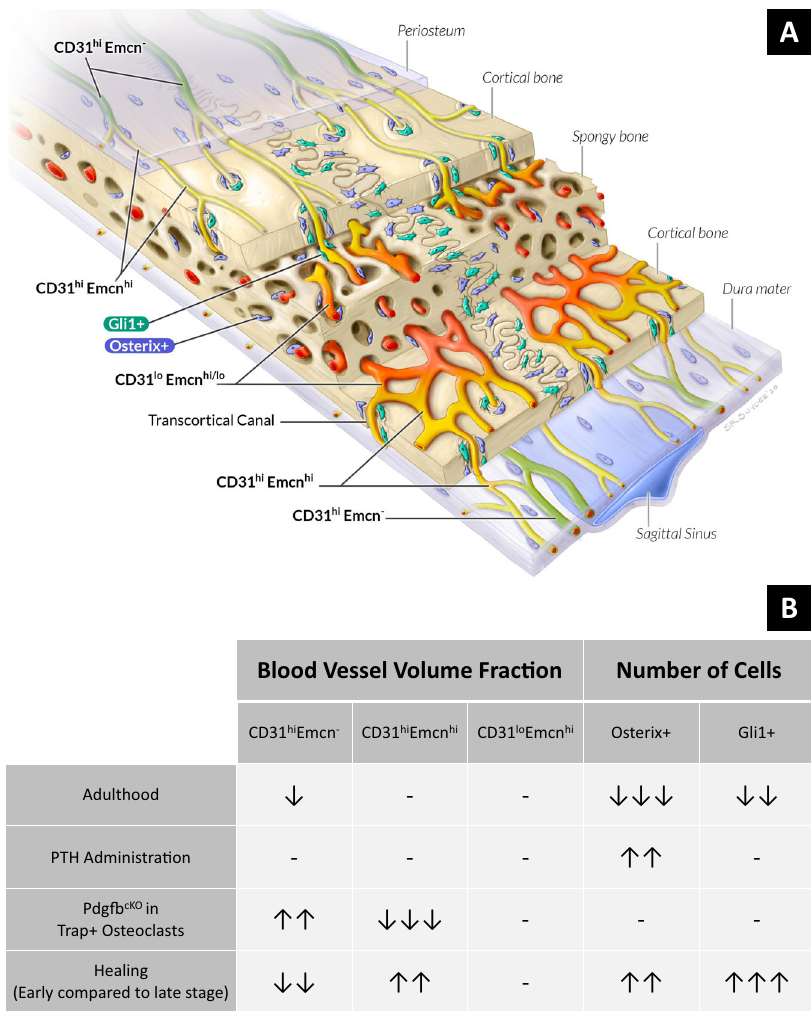
Fig. 7 Schematic representing the spatial distribution and prevalence of vessels and skeletal progenitors in the calvarium. A Illustration showing the relative locations of the vessel and skeletal progenitor subtypes in the parietal bones from 4-weeks-old mice, as derived from Fig. 2. B Table demonstrating how the fractional volume of vessel subtypes and number of skeletal progenitors change during postnatal growth, alterations to remodeling, and